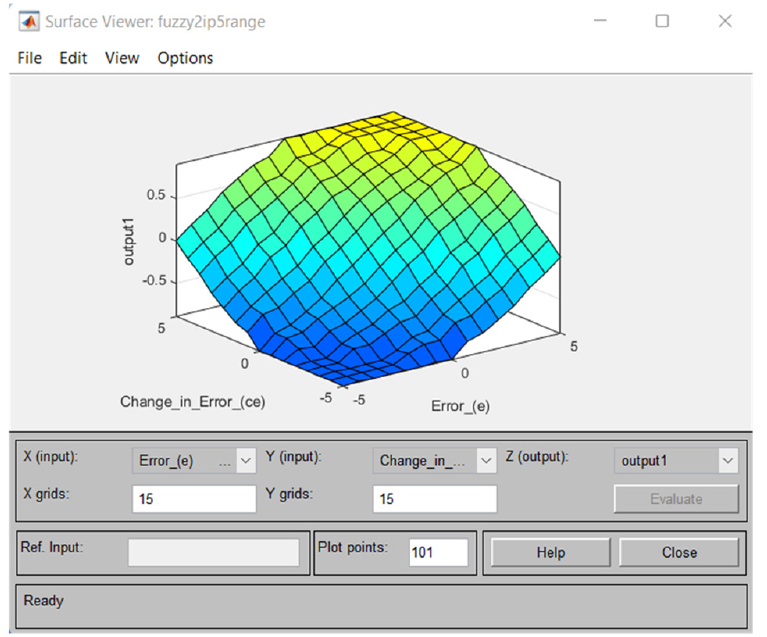
Figure 15. Surface plot of the fuzzy layout.